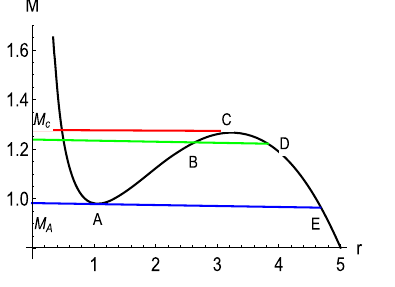
Fig. 1 M − r diagram for Q = 1, α = 0 . 01, ω = − 2 / 3, l 2 = 37 . 386